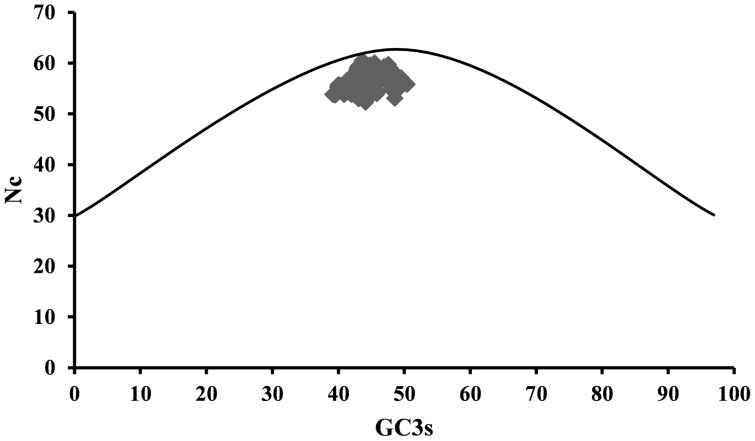
Nc of codons used plotted against the GC3s.The continuous curve as seen in the plot represents the relationship between GC3s and the Nc in the absence of selection. All the values lie below the expected curve. The curve represents the expected codon usage if GC compositional constraints alone account for codon usage bias.